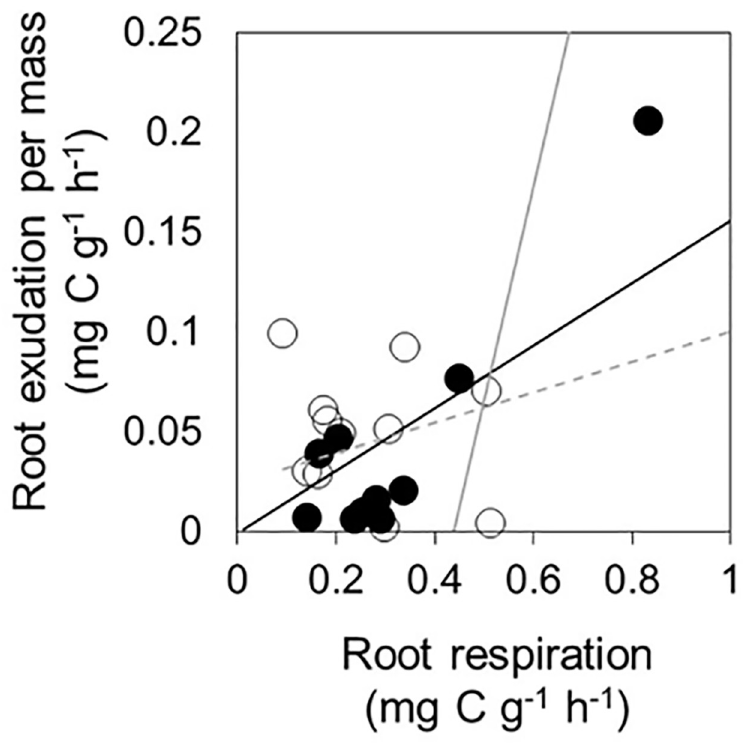
Fig 2. Relationships between root respiration and exudation per mass. Unfilled and filled circles indicate upper and lower plots on slope, respectively. Solid line, correlation between root respiration and exudation (exudation = 0.16 × respiration + 0.00, R2 = 0.31, P < 0.01). Gray and dotted lines, correlation in cool-temperate [14] and temperate [2] Quercus forests,